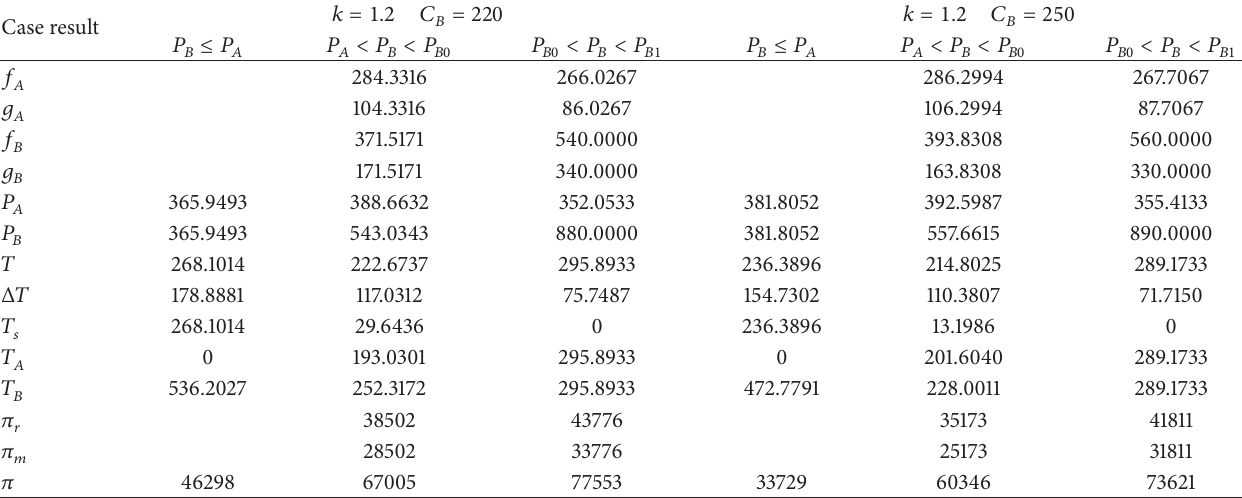
Table 2: The effect of RP cost changing in Stackelberg-Nash game ( 𝑘 = 1.2 ).